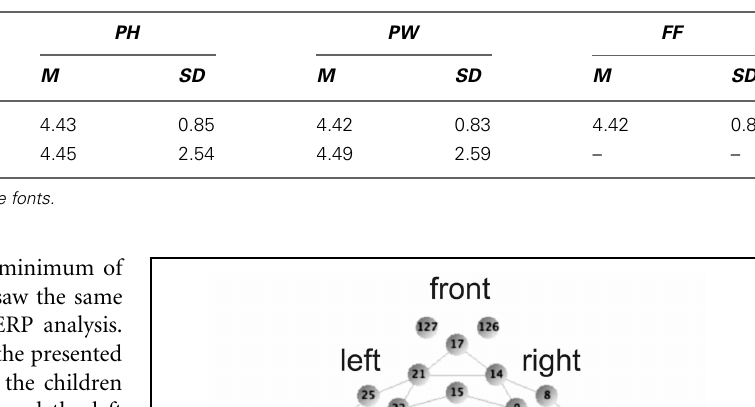
Table 2 | Item characteristics for each condition.